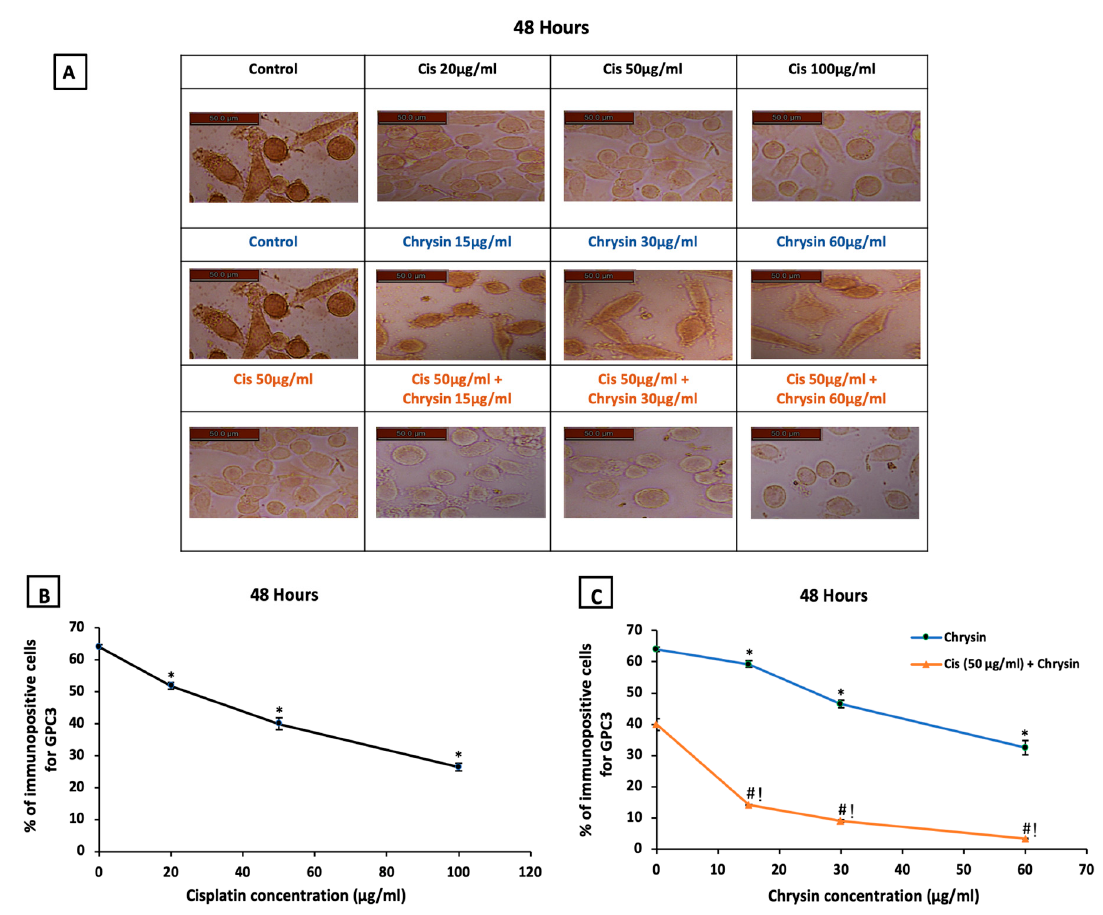
Figure 3. ( A ) Representative images of glypican-3 (GPC3) immuno-staining in HepG2 cells following treatments with cisplatin (Cis; 20, 50, 100 µ g / mL), chrysin (15, 30, 60 µ g / mL) and combination of chrysin (15, 30, 60 µ g / mL) with Cis 50 µ g / mL for 48 h, scale bar = 50 µ m. Control untreated cells showed strong GPC3 immunopositive stain, Cis (20, 50, 100 µ g / mL) treated cells showed mild GPC3 immunopositive stain, chrysin (15, 30, 60 µ g / mL) treated cells showed GPC3 moderate immunopositive stain while, Cis 50 µ g / mL + (15, 30, 60 µ g / mL) treated cells showed weak GPC3 immunopositive stain. ( B ) Statistical analysis of the % of immunopositive cells for GPC3 after treatment with cisplatin (Cis; 20, 50, 100 µ g / mL) for 48 h, ( C ) chrysin (15, 30, 60 µ g / mL) as well as chrysin (15, 30, 60 µ g / mL) and Cis 50 µ g / mL combination for 48 h. * p < 0.05 versus the control untreated cells. # p < 0.05 versus the same dose of chrysin. ! p < 0.05 versus Cis 50 µ g / mL. Figures for the control group in the upper and middle lanes and for the Cis 50 µ g / mL group in the upper and last lanes are identical to unify the reference groups in the statistical